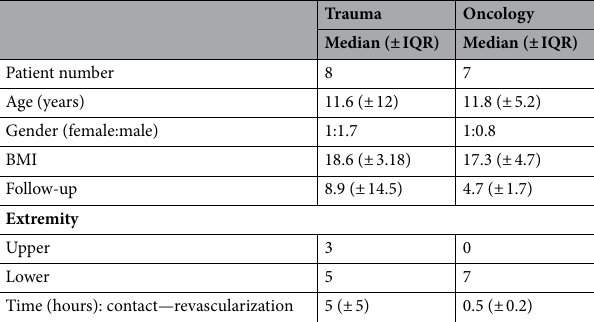
Table 1. Trauma vs. oncologic surgery group.